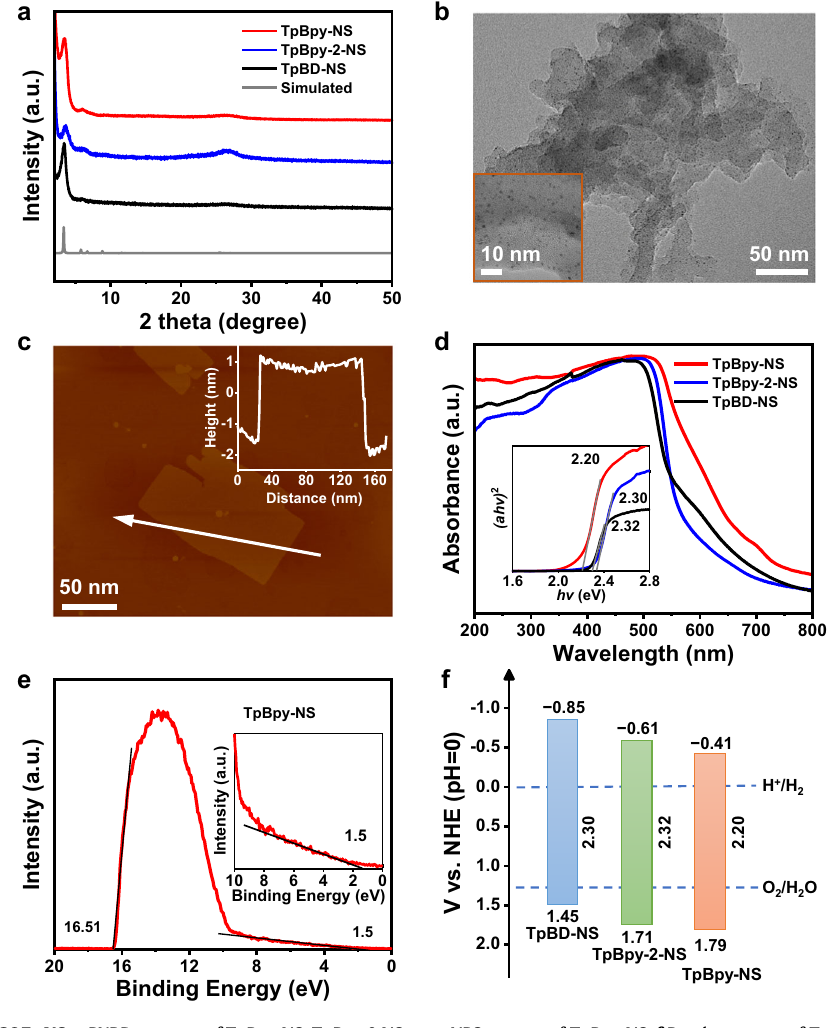
Fig. 2 |CharacterizationsofCOFs-NS. a PXRD patternsofTpBpy-NS, TpBpy-2-NS, and TpBD-NS. b TEM image, c AFM image of Pt@TpBpy-NS. Scale bar: 50nm. d UV – Vis DRS, and ( ahv ) 2 versus hv curve ofTpBpy-NS, TpBpy-2-NS, and